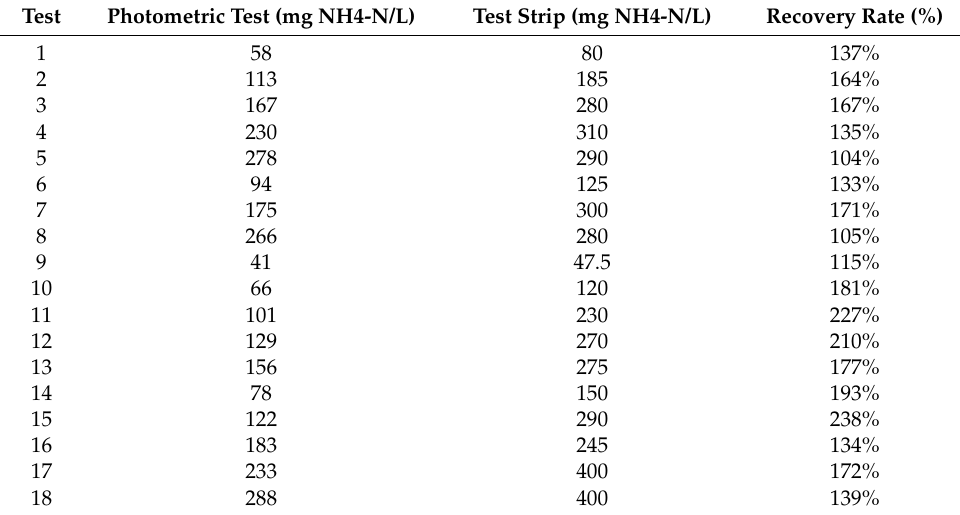
Table A11. Raw data photometric testing vs. test strips.